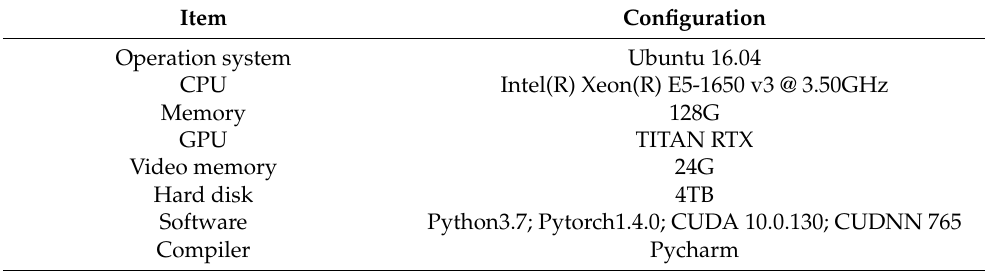
Table 3. Experimental environment of software and Table 2. The training parameters of the proposed algorithm.